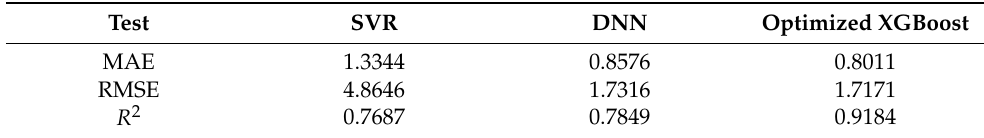
Table 5. Comparison of prediction results of SVR, DNN, and optimized XGBoost models on the unseen test